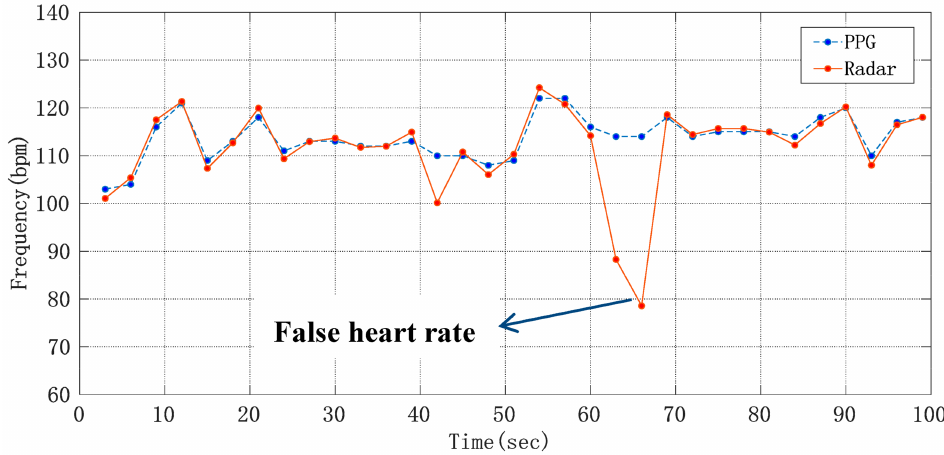
Figure 17. Diagram about how short-term heart rate changes with time.